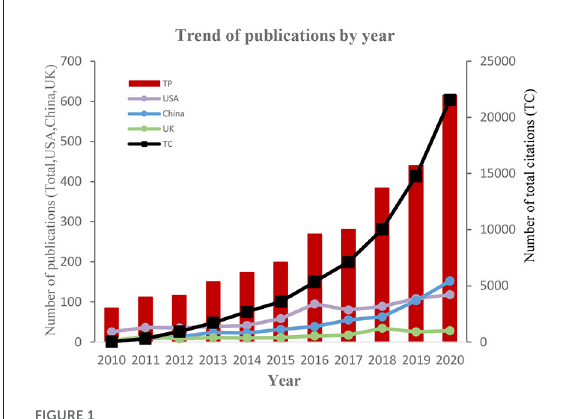
FIGURE1 Trends in the number of published articles related to ARB by year. TP, total papers; TC, total citations.